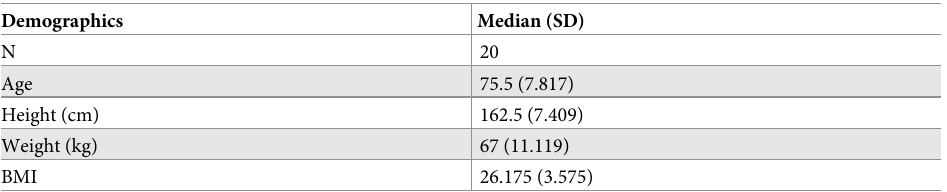
Table 1. Orthogeriatric study